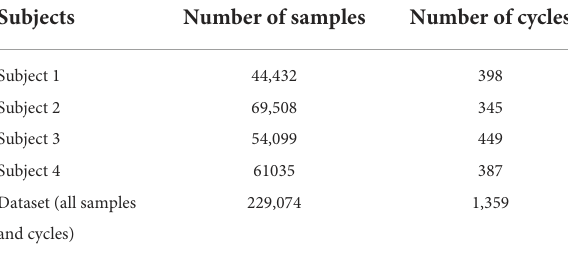
TABLE 2 The number of samples and cycles of the